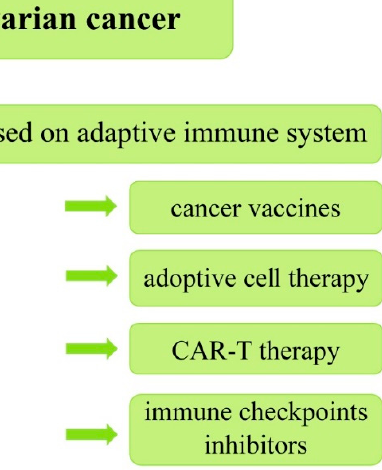
Figure 1. Classification of immunotherapy of ovarian cancer based on the innate and adaptive immune system .